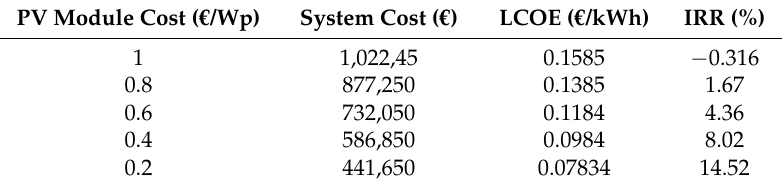
Table 12. Comparison of LCOE and IRR based on a recovery factor at 10% interest, for the 500 kW case.